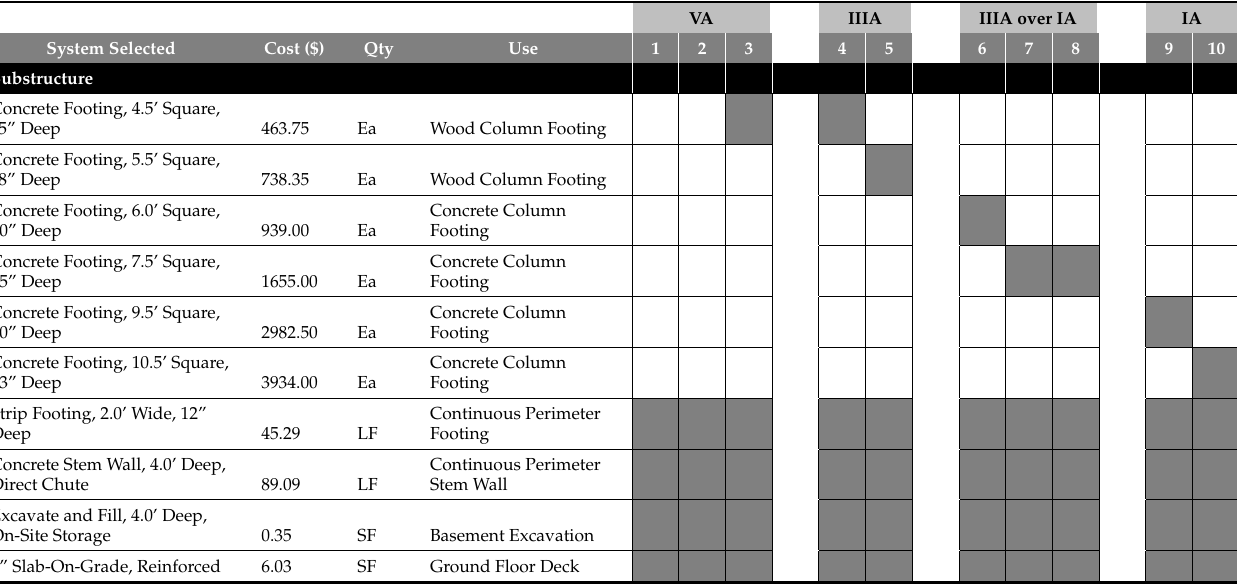
Table 1. Substructural Systems, Costs, and Designated